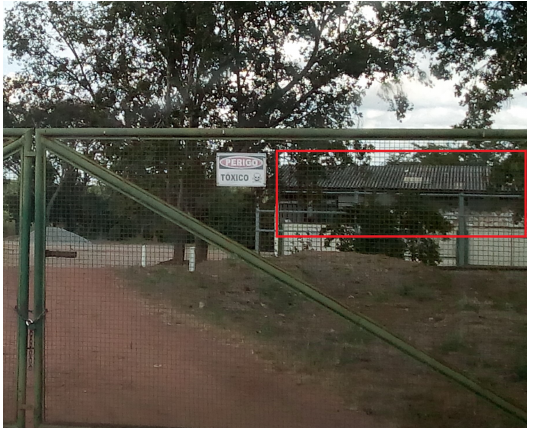
Figure 1. Disposal location center. The red line details empty agrochemical containers inside a